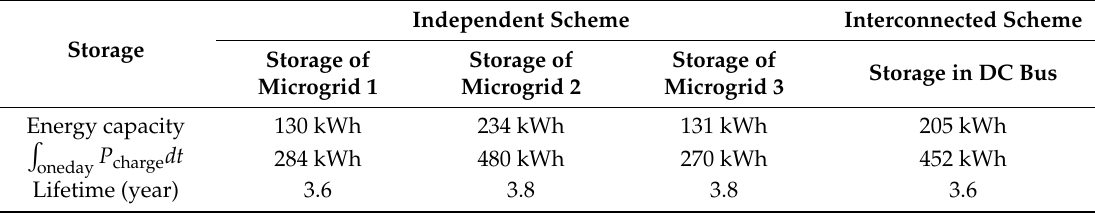
Table 7. Lifetime determination of storage in di ff erent